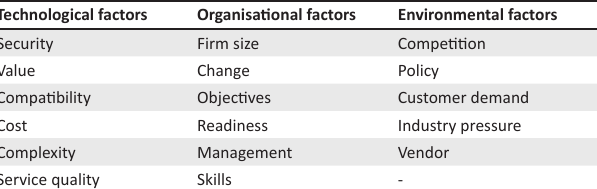
TABLE 1: Technological, organisational and environmental factors influencing the adoption of contactless technologies in supply chain and logistics. Technological